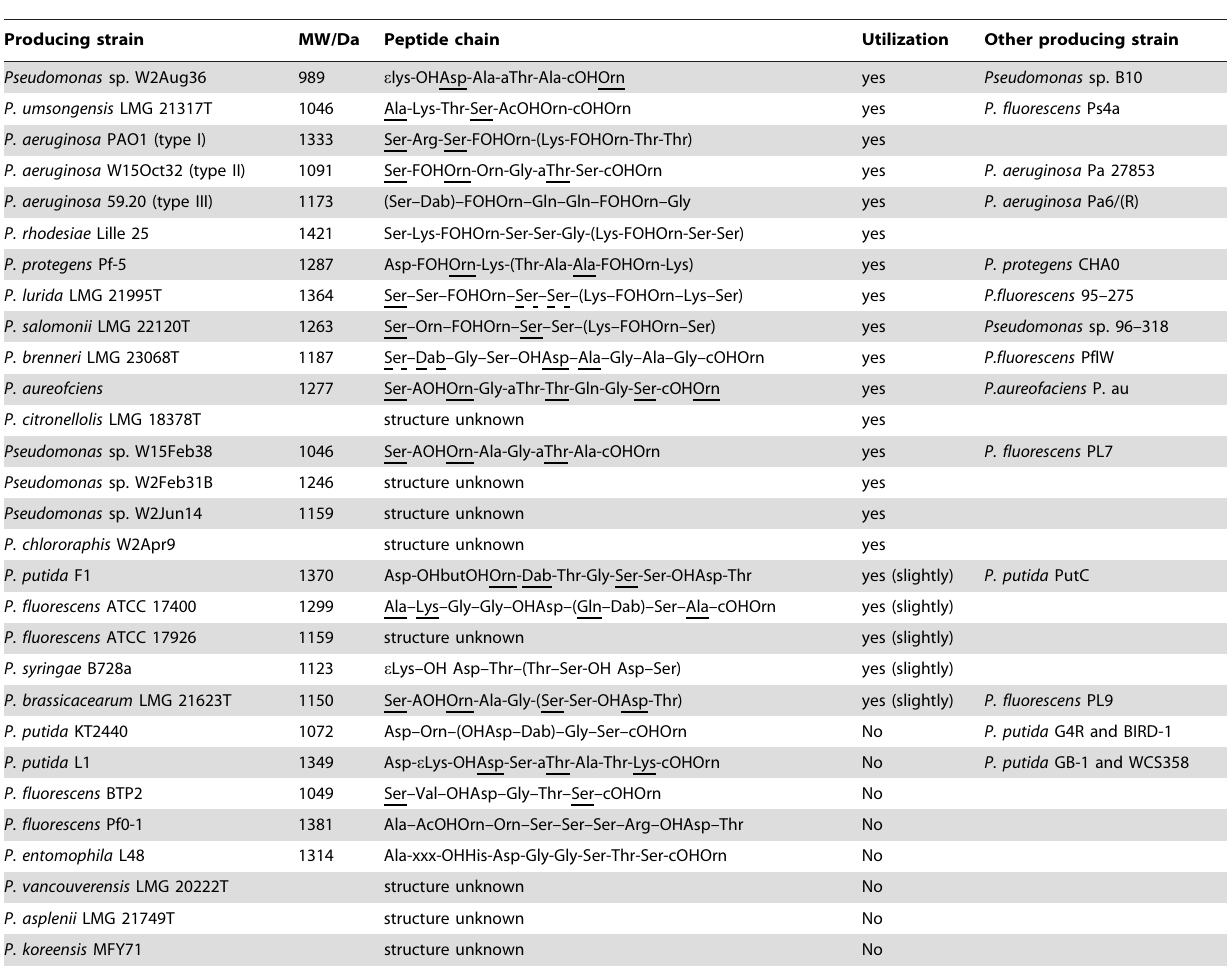
Table 2. Pattern of pyoverdines utilization by the pvdL -pyoverdine-negative mutant.